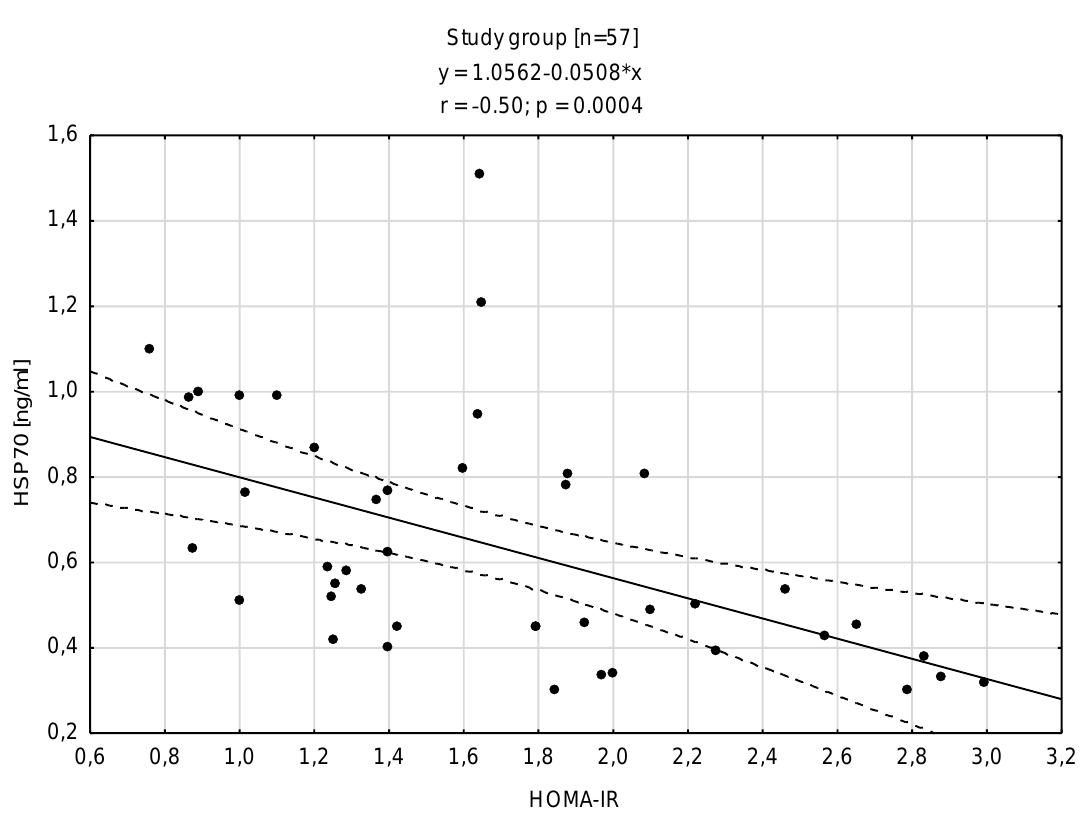
Figure 5. Relationship between the concentration of HSP70 in the blood serum and the HOMA-IR index.